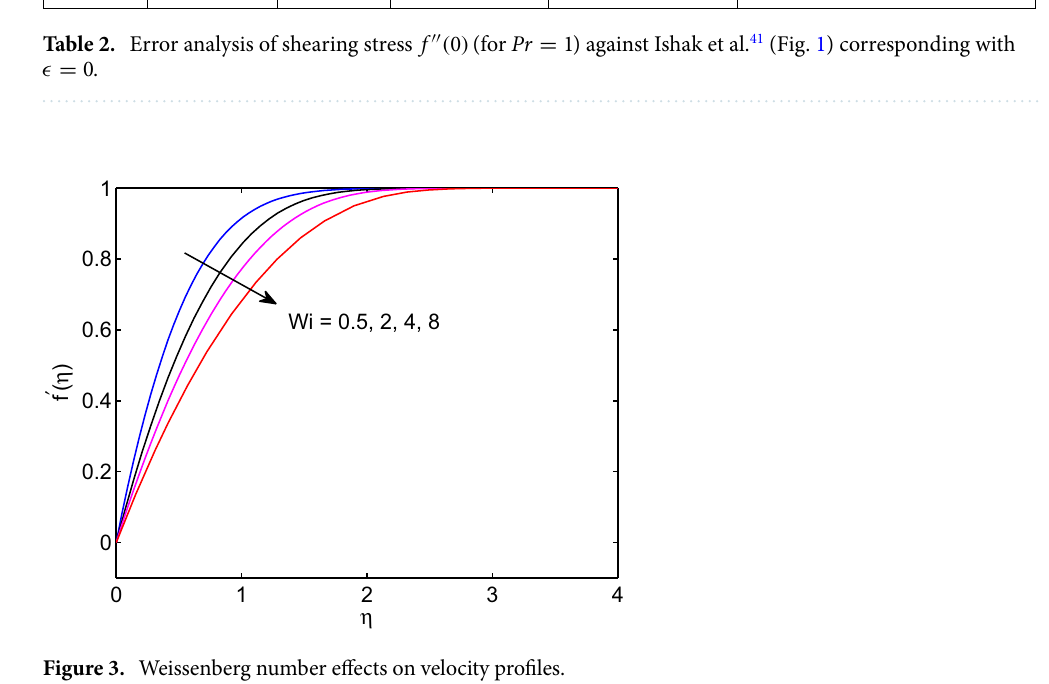
Figure 3. Weissenberg number effects on velocity profiles.